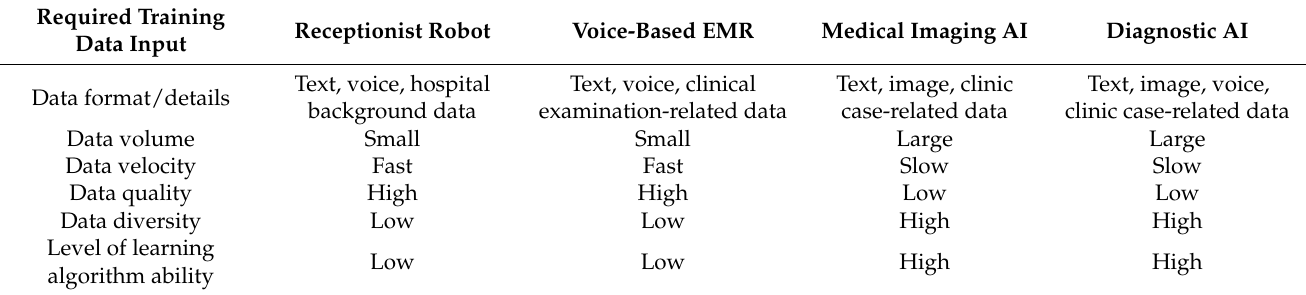
Table 7. Learning algorithm ability and training data of